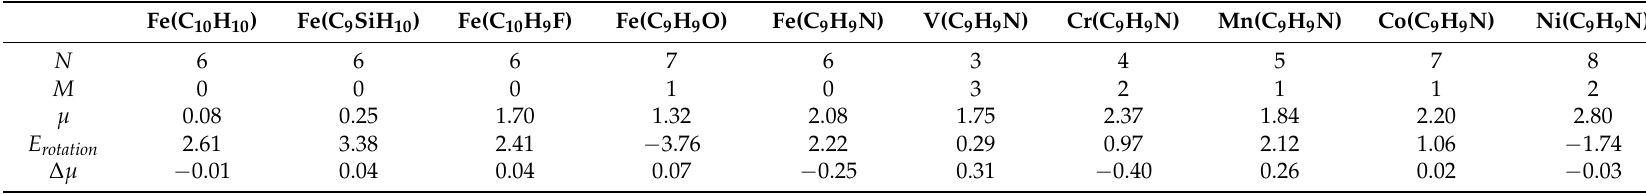
Table 2. Number of 3 d electrons on the transition metal (TM) ions (N); magnetic moment (M, µ B), dipole moment ( µ , D) of isolated metallocene molecules; rotation barriers ( E rotation = E staggered − E eclipsed , kJ/mol) and dipole moment differences ( ∆ µ = µ staggered − µ eclipsed , D) between the two different